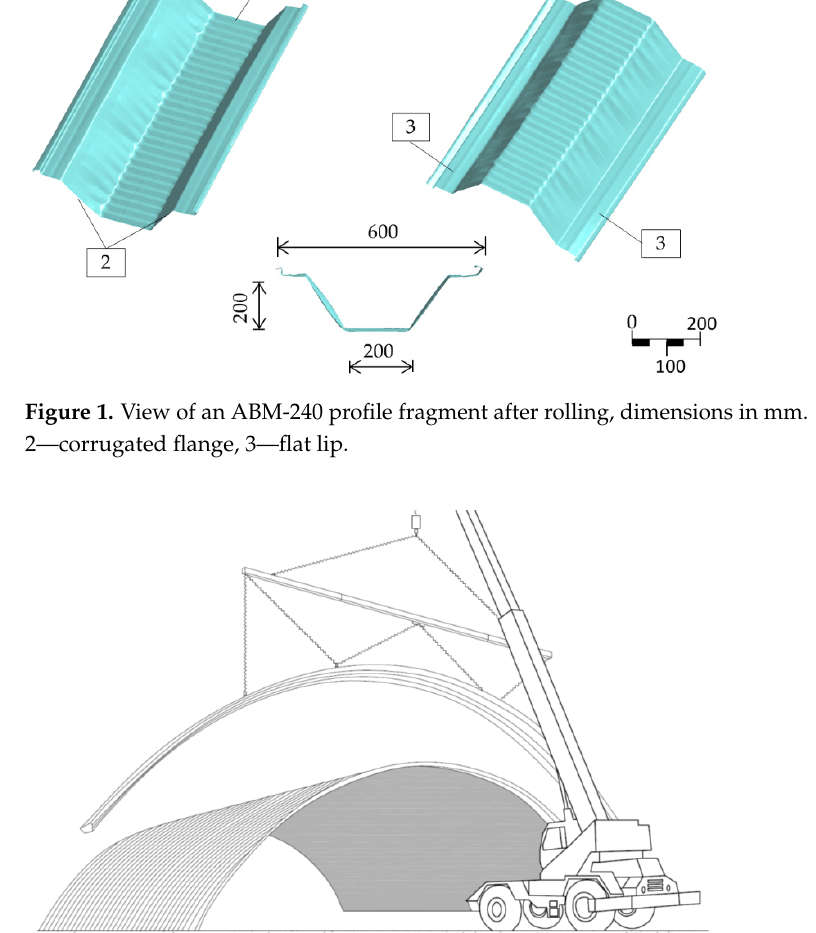
Figure 1. View of an ABM-240 profile fragment after rolling, dimensions in mm. 1—corrugated web, 2—corrugated flange, 3—flat lip.